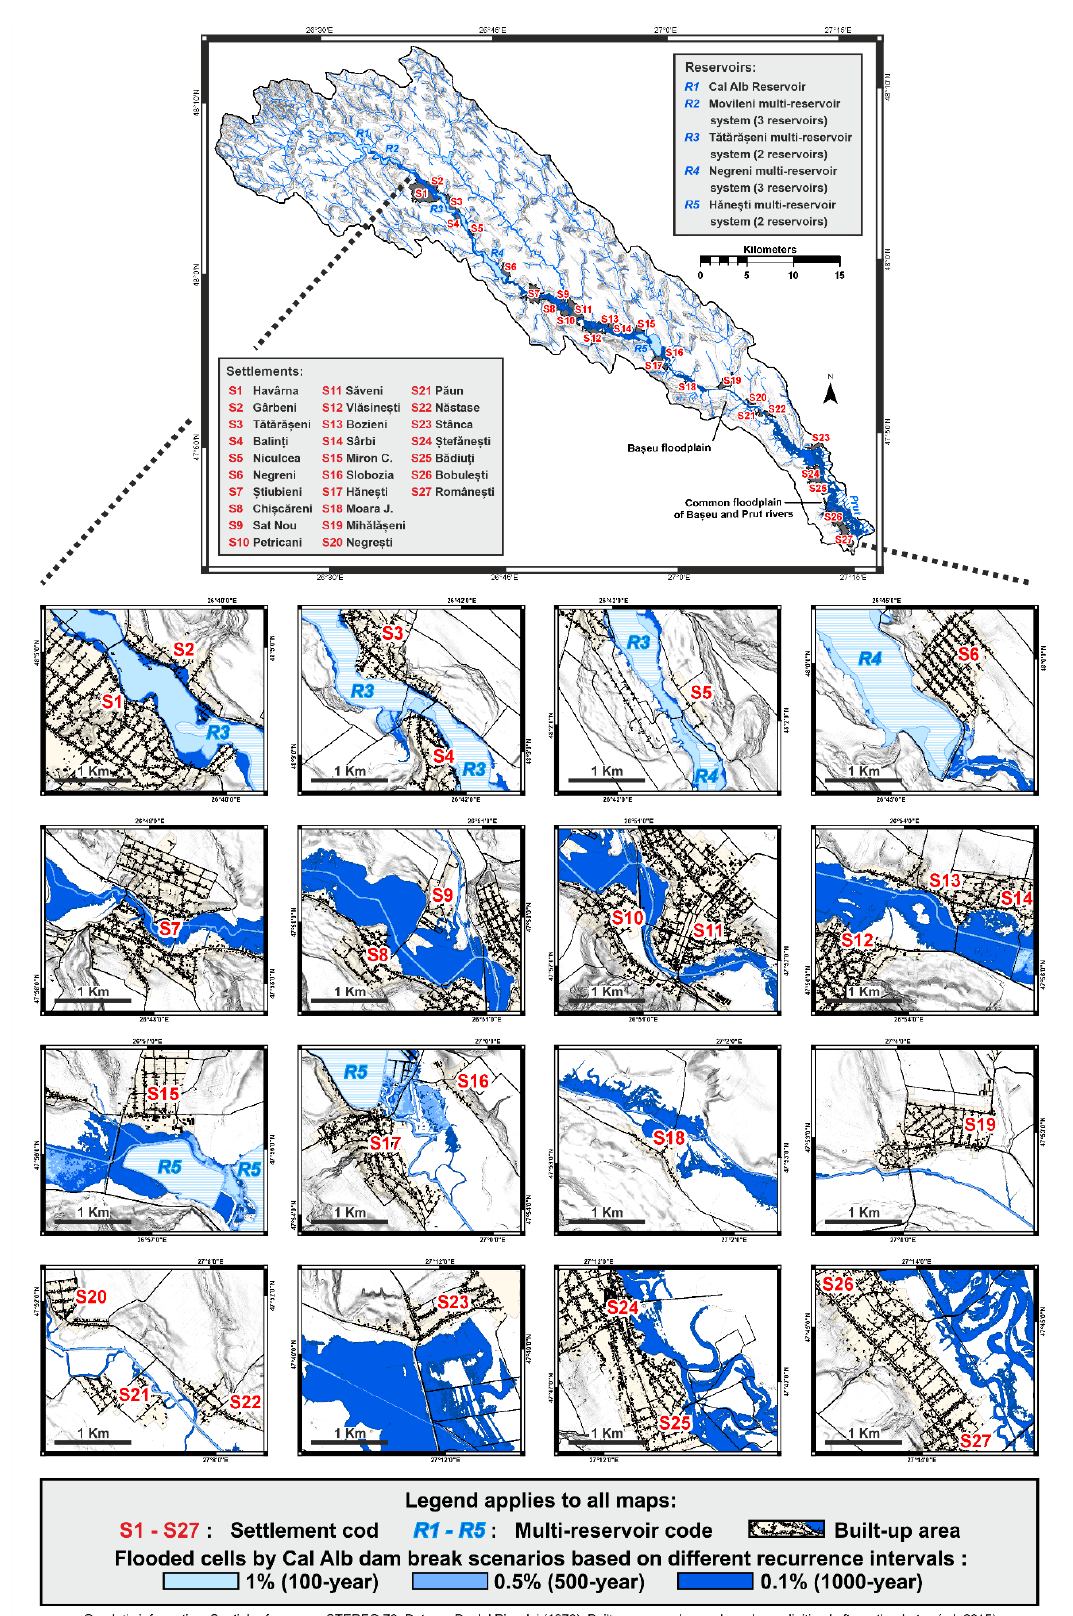
Figure 4. Flood extent within built-up area of 27 settlements located downstream of the Cal Alb reservoir computed for each dam break scenario with 1% (100-year), 0.5% (500-year), and 0.1% (1000-year) recurrence intervals.